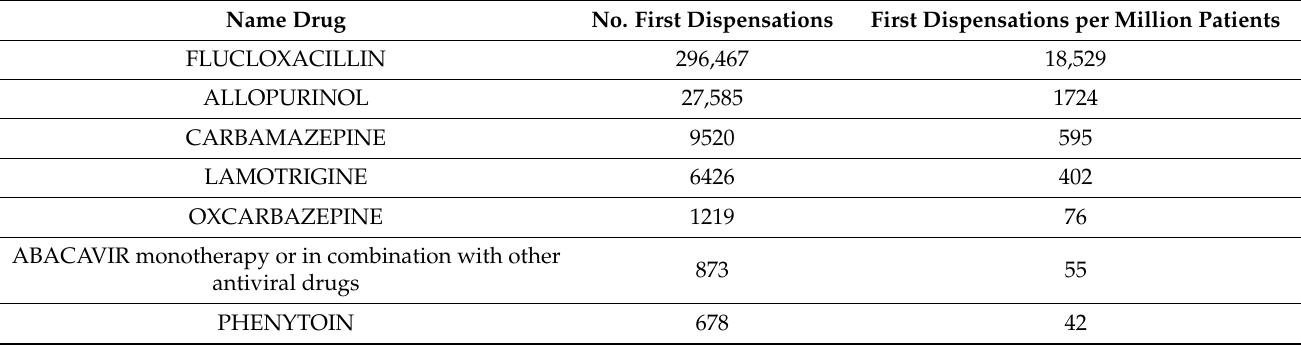
Table 1. An overview of the first dispensations for drugs with an actionable HLA associated DPWG recommendation dispensed in Dutch pharmacies